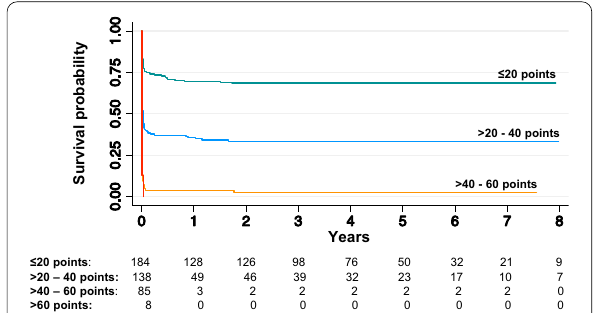
Fig. 1 Kaplan–Meier survival estimates with number at risk for predefined OHCA score categories. Below the x -axis, number at risk for the individual time points are reported